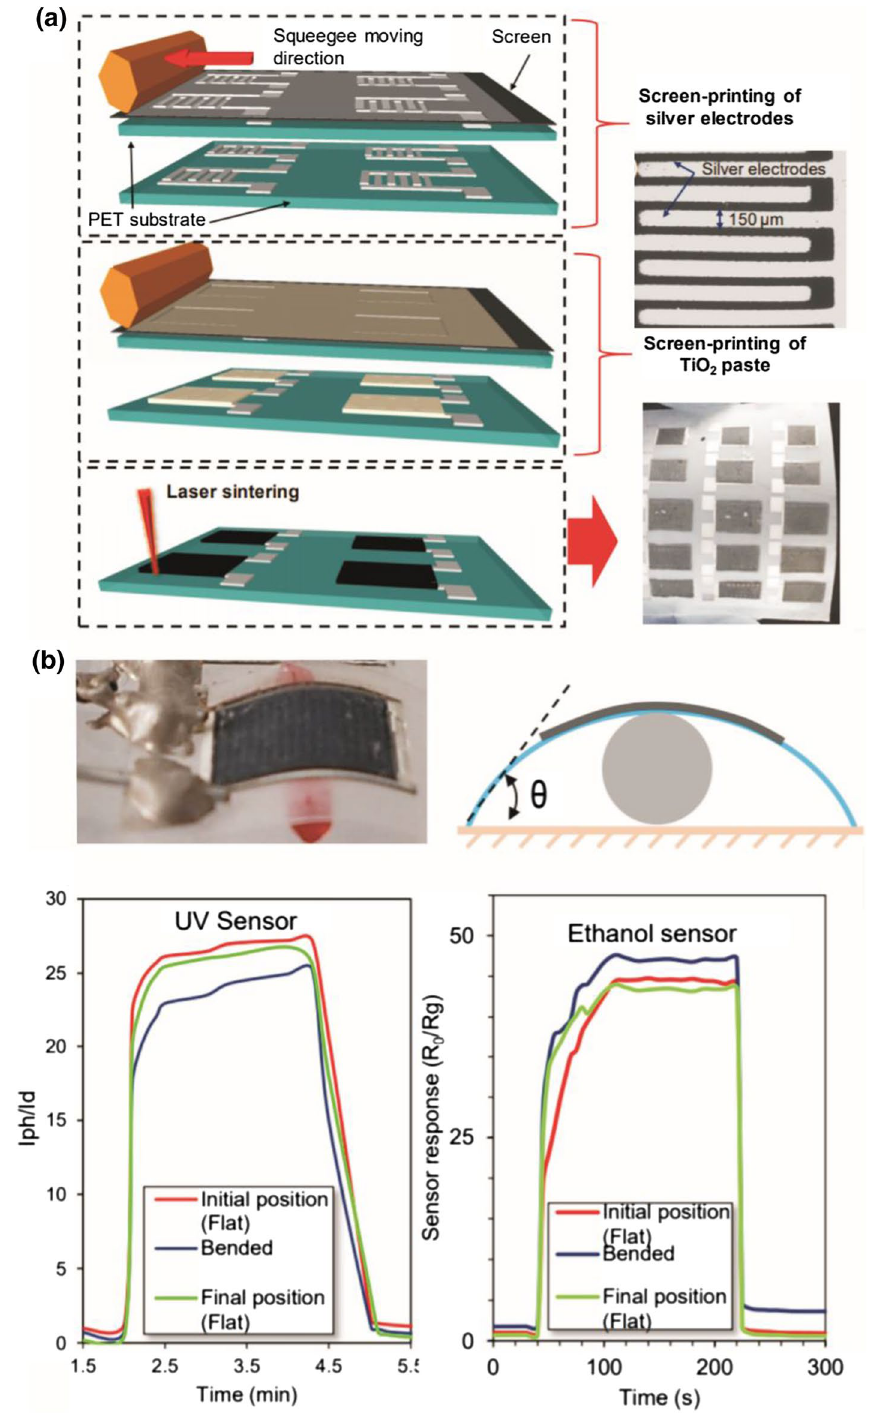
Fig. 6 a Schematic of the sensor fabrication process, together with the SEM image of the silver electrodes and optical image of the sintered device matrix fabricated on PET substrate. b Optical image of the fabricated flexible TiO -based sensor, and sche- 2 matic of the bending with cor- responding curvature angle. The time-resolved of UV sen- sor responses for the 0.19 J. cm −2 treated TiO film under 2 UV light and bended, together with the time-resolved of ethanol responses for the 0.17 J.cm −2 treated TiO film 2 at 100 ppm under bending are also presented. Reprinted with permission from “Mul- tifunctional screen-printed TiO nanoparticles tuned by 2 laser irradiation for a flexible and scalable UV detector and room-temperature ethanol sensor, ACS Appl. Mater. Inter- faces 2019, 11, 6,